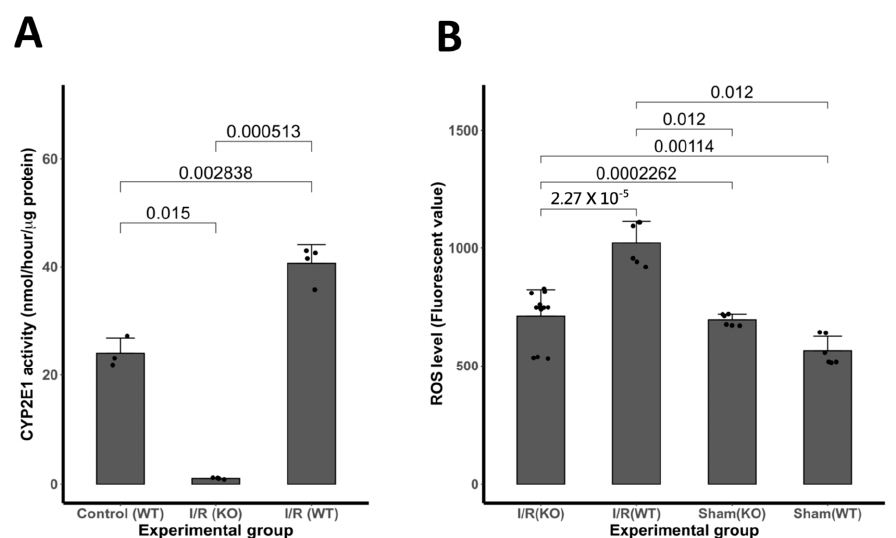
Figure 2. ( A ) CYP2E1 activity increases following I/R. Mice transient MCAo (tMCAo; 90 min occlusion and 24 h of reperfusion) models are compared with controls for cerebral CYP2E1 activity at 24 h. CYP2E1 activity was assessed by the nitrocatechol method [28]. CYP2E1 activity was increased significantly (61%) following transient MCAo compared with age- and sex-matched controls ( n = 7). No significant CYP2E1 activity was found in the CYP2E1( − / − ) group. ( B ). Ninety minutes I/R increases Reactive oxygen species (ROS) production in the brain, as determined by using chloromethyl derivative of dichlorofluorescein diacetate (MC-H 2 DCFDA) at 24 h post-reperfusion. The fluorescent signals generated with MC-H 2 DCFDA in the brain were increased with the insult of I/R. The analysis of fluorescence intensity illustrates the significant reduction in ROS production in CYP2E1( − / − ) mouse after the insult of I/R in comparison to age-matched WT mice. No fluorescence was detected in wells without the incubation of MC-H 2 DCFDA. Data are shown as mean + SD. n = 6 male per